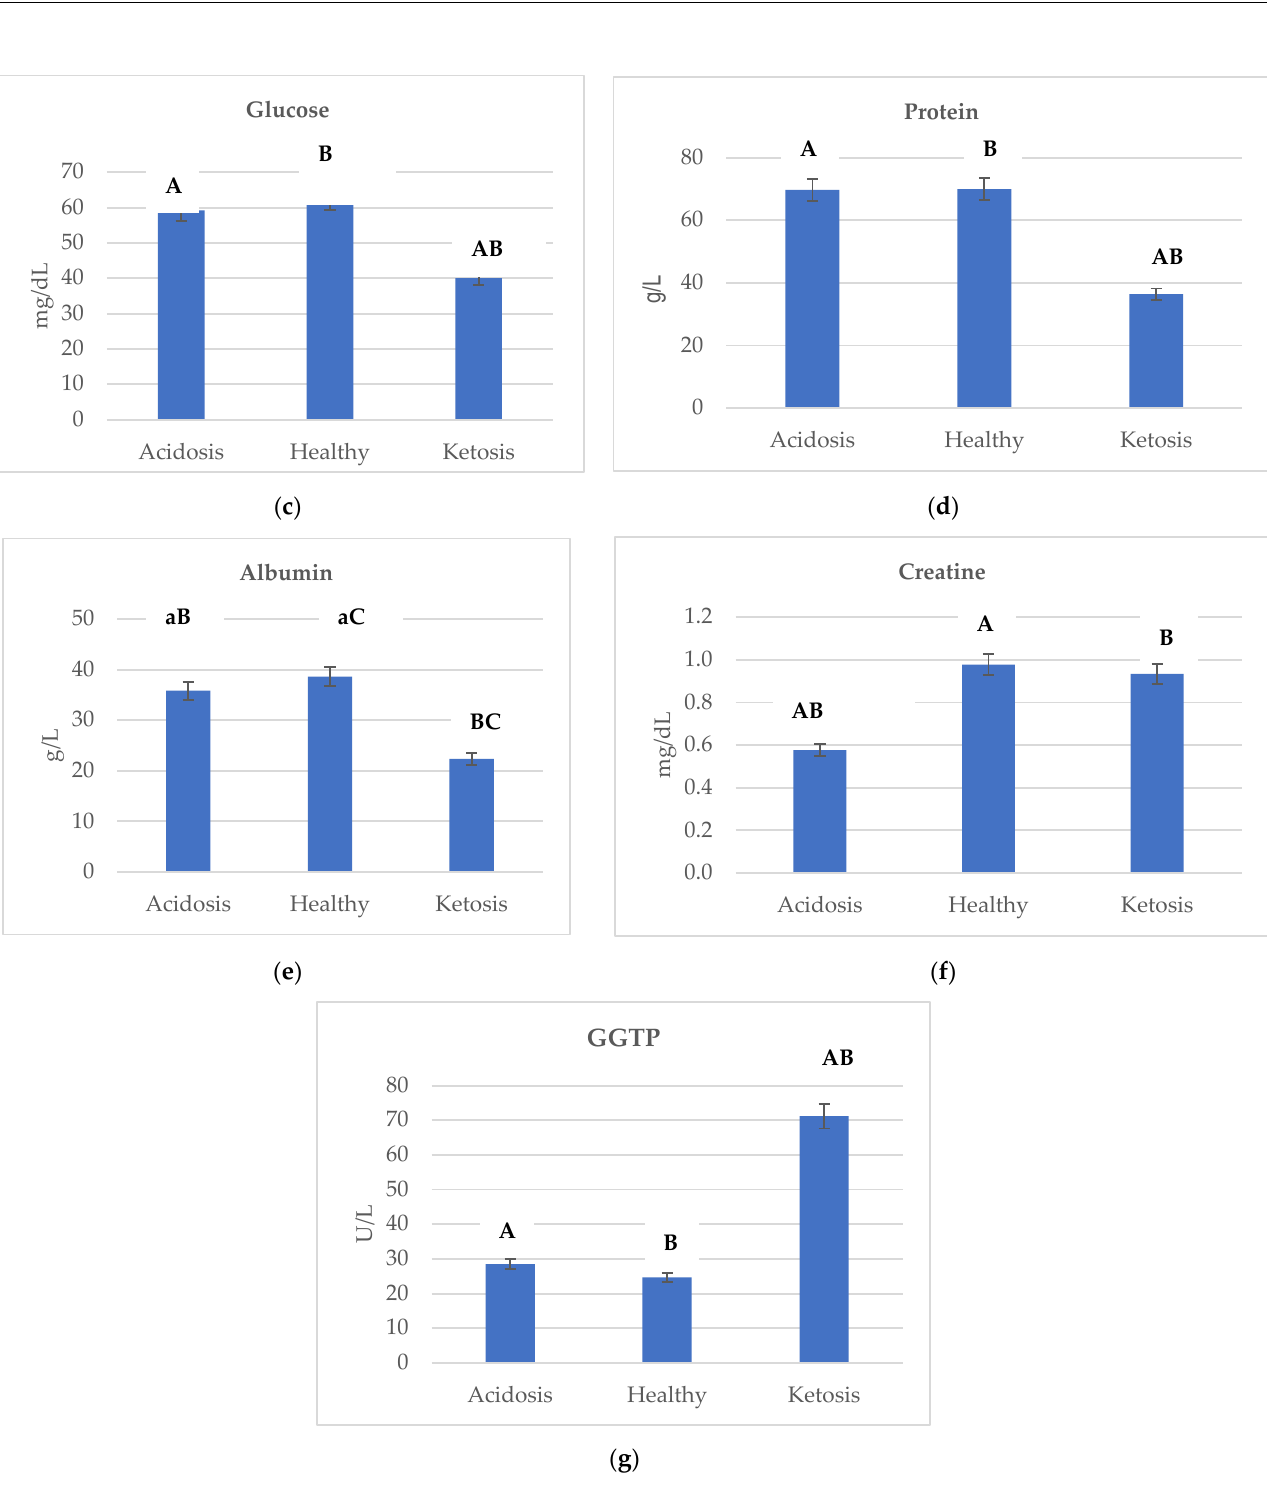
Figure 2. Changes in the concentration of ( a ) bilirubin, ( b ) AspAT, ( c ) glucose, ( d ) protein, ( e ) albumin, ( f ) creatine, and ( g ) GGTP depending on the health status of cows. Data were presented as least squares means with a standard error of the mean. Means marked with the same letters differ significantly at lowercase letters, p ≤ 0.05; uppercase letters, p ≤ 0.01. AspAT, aspartate aminotransferase; GGTP, gamma-glutamyltranspeptidase.